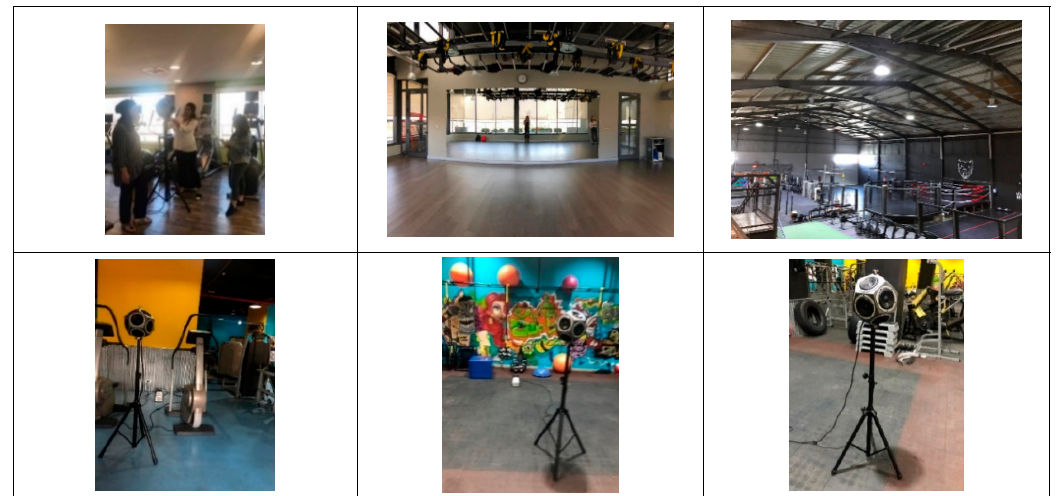
Figure 1. Representative photos taken during measurements of reverberation time and noise levels inside the studied indoor sports and gymnasium (IS & G) halls.